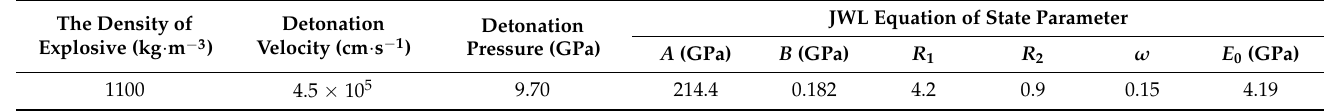
Table 6. The parameters of the